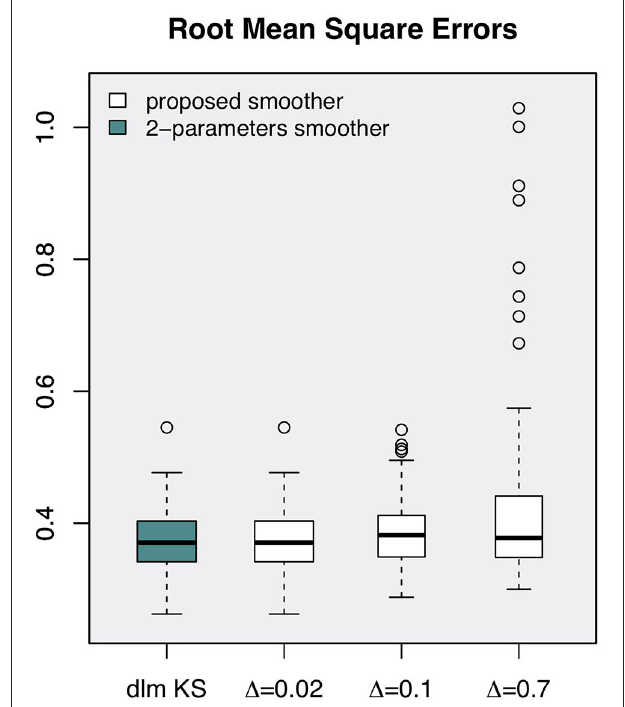
FIGURE 2 | Root Mean Squared Error (RMSE) obtained for the prediction of the true underlying signal by the two-parameter exact smoother and by our method on data sets simulated with no outliers, no censoring, δ = 0 and η = 1 and with varying values of the discretization step, 1 . As expected, in this ideal setting, the 2-parameters Kalman smoother implemented in the DLM R package and our method give identical results for 1 =